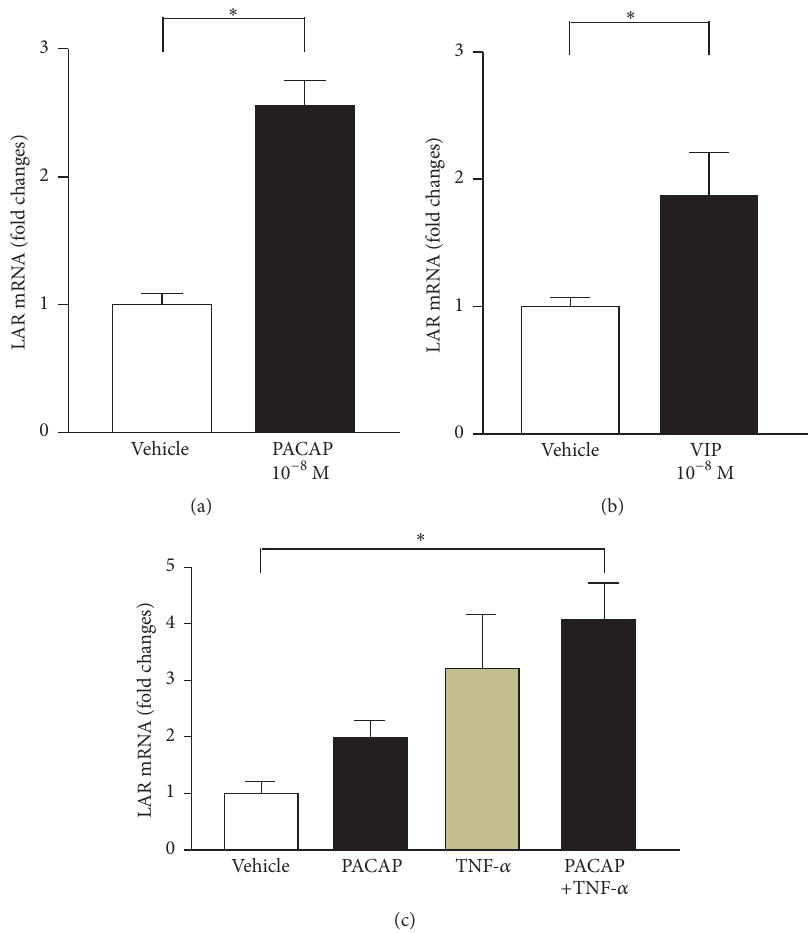
Figure 5: LAR expression in liver slice. (a) and (b) LAR mRNA expression in liver slices cultured with 10 −8 M PACAP (a) or 10 −8 M VIP (b) for 24 h. 𝑛 = 4 for each group. (c) LAR mRNA expression in liver slices cultured with 10 −9 M PACAP and/or 10 −10 M TNF- 𝛼 for 24 h. 𝑛 = 3 for each group. Each bar represents mean ± s.e.m. ∗ 𝑝 < 0.05